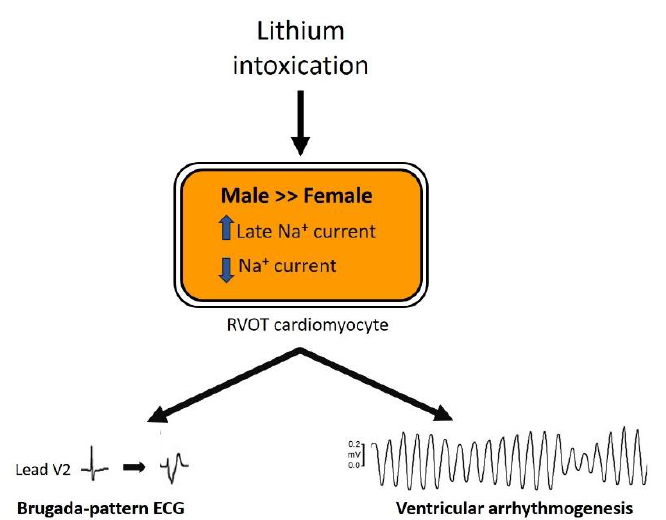
Figure 8. The underlying mechanisms driving the differences in lithium-induced electrical changes and arrhythmogenicity between genders. The up arrow represents an increase in current density; the down arrow represents a decrease in current density. ECG, electrocardiography; Na, sodium; RVOT, right ventricular outflow tract.